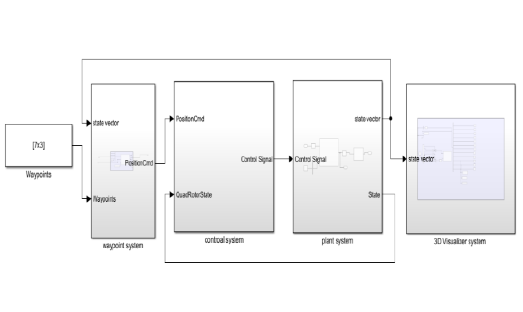
Figure 1. Simulink and simulation quadcopter model